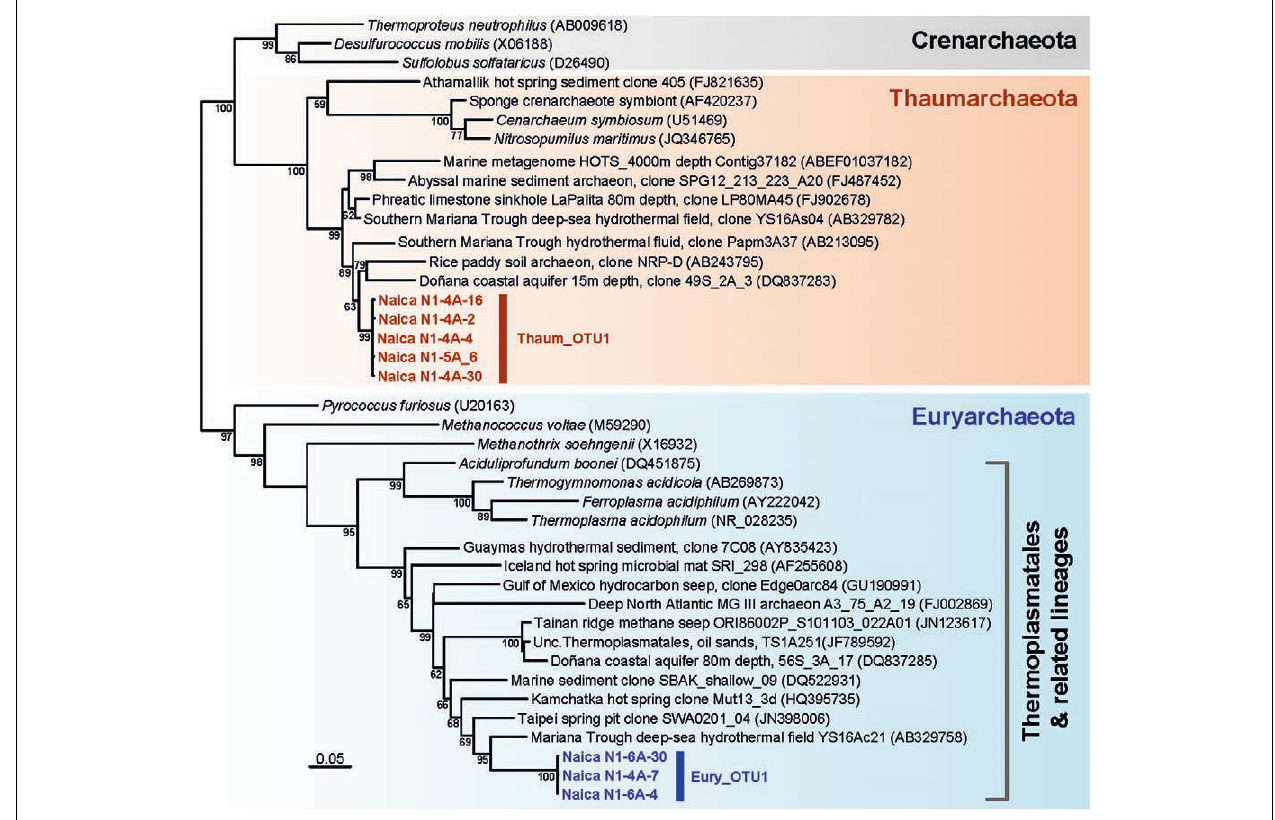
FIGURE 3 | Maximum likelihood phylogenetic tree of archaeal 16S rRNA genes retrieved from Naica deep hot springs. The tree was reconstructed using 1,079 positions. Sequences obtained in this work are shown in color.